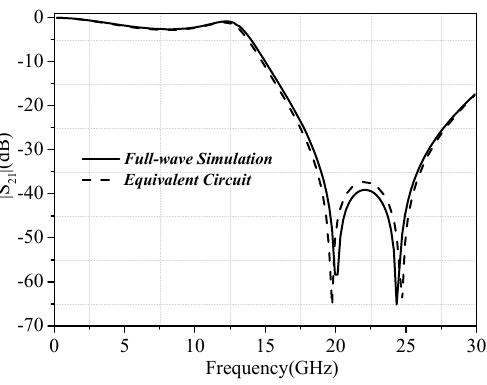
Figure 7. Transmission coefficients for oblique incidences with different angles on the harmonic suppression (HS) FSMSE, ( a ) TE polarization and ( b ) TM polarization. Next, the designed harmonic suppression FSMSE can be integrated with the aforementioned non-resonant patch-grid FSS and the resonant complementary loop FSS, respectively, as shown in Figures 8 and 9. The air spacing h1 between the two original FSSs and the HS-FSMSE was also optimized using circuit analysis where the two types of FSSs are equivalent to band-pass circuits whose lumped elements can also be extracted by bisquare fitting algorithm. When h1 is 3 mm, the harmonic suppression feature can perfectly be achieved without deteriorating the operating frequency of the pass band. Figure 10 shows the transmission coefficient of non-resonant patch-grid FSS with HS-FSMSE for different incidence angles with TE and TM polarizations. It can be seen that the high-order harmonic waves can be suppressed below − 40 dB after integrating with HS-FSMSE structure. Similarly, Figure 11 depicts the transmission coefficient of the resonant complementary loop FSS with HS-FSMSE for different incidence angles with TE and TM polarizations. The results show that the high-order harmonic waves can also be well suppressed even with the strong resonant behavior. In the meantime, we can see that the two different types of FSSs with same HS-FSMSE own good polarization and angle stabilities. It can be seen that the FSS with narrower bandwidth will be less affected after HS-FSMSE is added. Hence, cascading HS-FSMSE layers to suppress spurious transmission of band pass FSS filters could be used for the applications which needs relatively narrow pass band. It is worth pointing out that the unit cell size of the patch-grid FSS and the complementary loop FSS are different. The patch-grid FSS is sub-wavelength structure whose period is only 6.6 mm, and the complementary loop is a conventional resonant structure whose period is 10 mm. For two different FSSs, the unit cell size of the harmonic suppression FSMSE is the same as 3.3 mm. As a result, when the HS-FSMSE is integrated with the patch-grid FSS, one unit corresponds to 2 × 2 HS- FSMSEs. And for the resonant complementary loop FSS, one unit corresponds to 3 × 3 HS-FSMSEs, as shown in Figures 8 and 10, respectively. In this case, the different implementations show the transplantability of the HS-FSMSE.